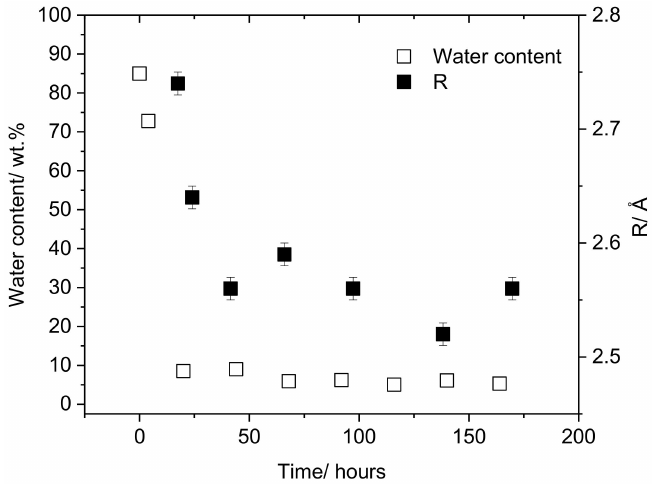
Figure 3. Decrease in non-plasticized PVA film water content over time during solution casting in air (hollow symbols) and decrease in cavity radius over time during the solution casting of films in air (filled symbols).